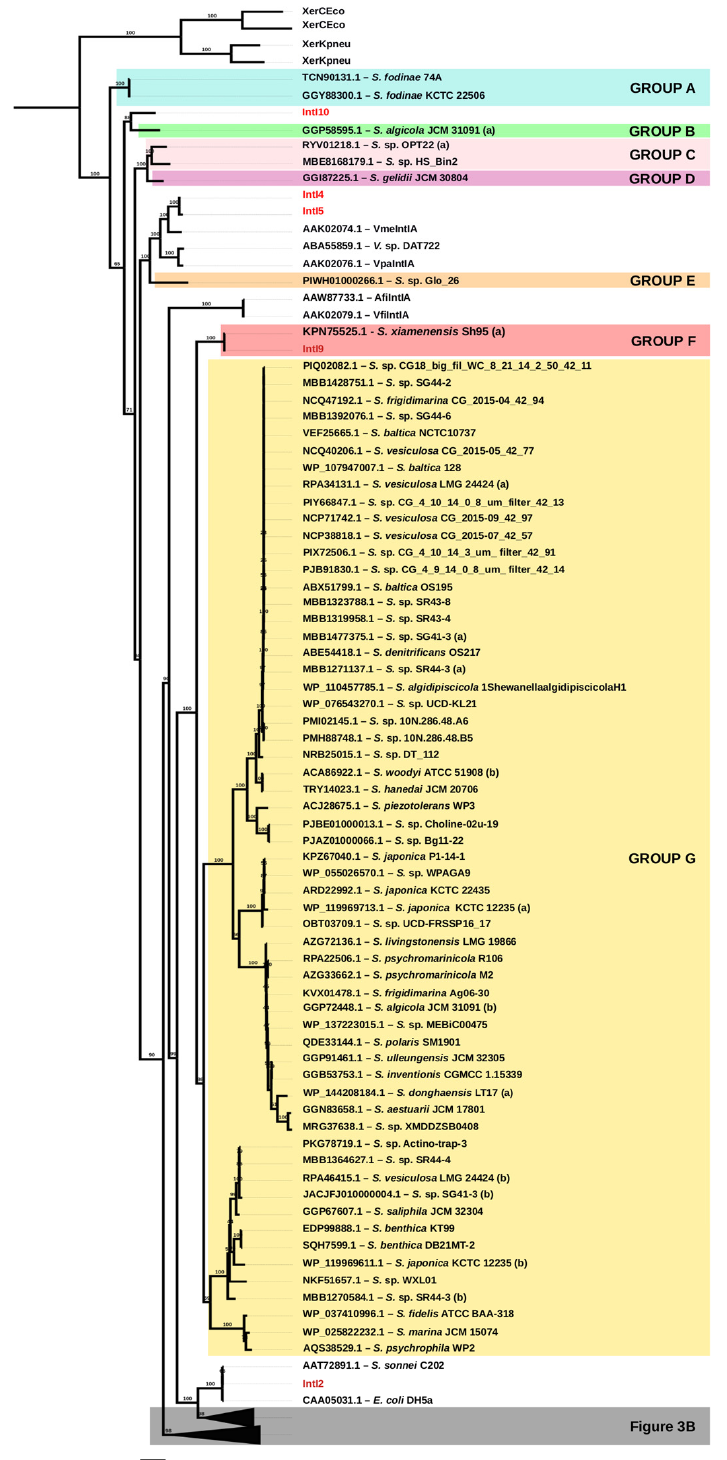
Figure 3. Phylogenetic tree of integron integrases found in Shewanella spp. ( A ) Depiction of branches from Groups A, B, C, D, E, F and G. ( B ) Depiction of branches from Groups H and I. Tree construction was done using the maximum-likelihood method with model LG + I + G4 and a bootstrap of 1000 replicates. IntI1 to IntI10 integron integrases are depicted in red. A detailed description of each group can be found in Table